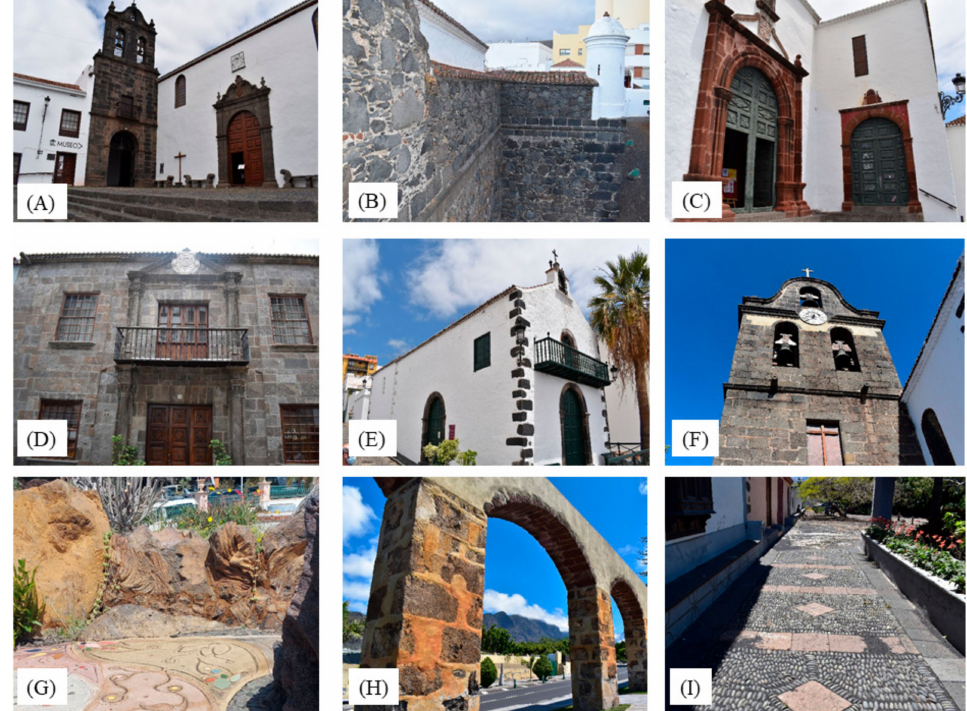
Figure 8. Cultural heritage in SCLP city: San Francisco Church ( A ), Santa Catalina Castle ( B ), Santo Domingo Church ( C ), Calle Real ( D ) and San Telmo Hermitage ( E ). In LLA city: Nuestra Señora de Los Remedios Church ( F ), G ó mez Felipe urban park ( G ), Argual aqueduct ( H ) and Argual plain and manor houses ( I ). Source: